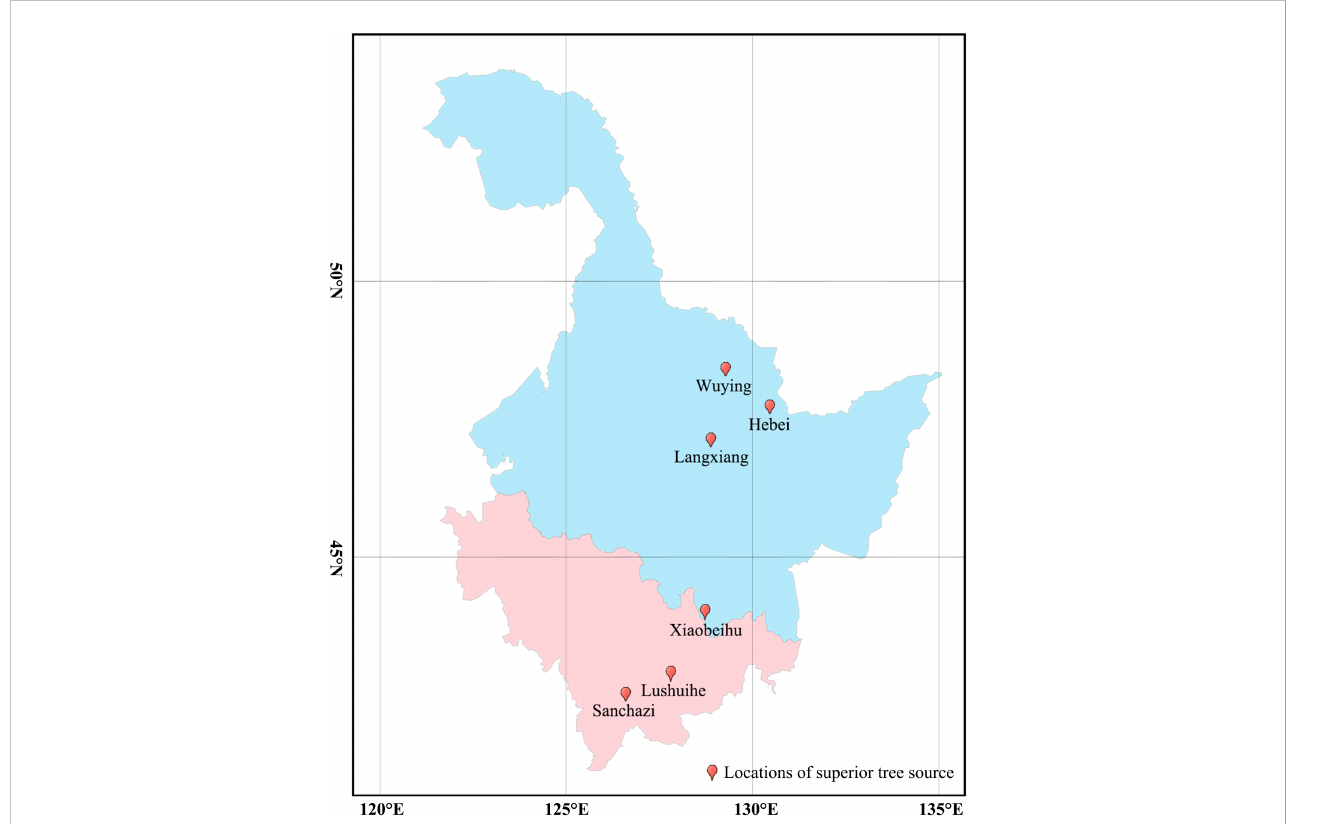
FIGURE 3 Geographical distribution of superior tree source of Korean pine populations. (Light blue indicates Heilongjiang Province and light purple indicates Jilin Province. The geographic conditions for each site can be found in Table 1).